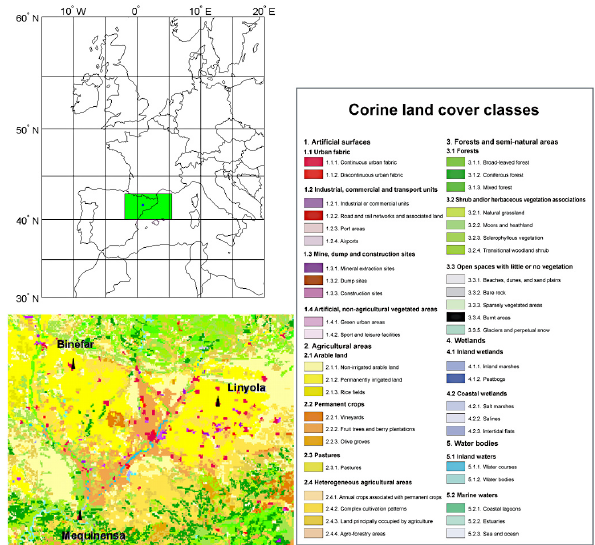
Fig. 1. Location map of the Linyola’s area and the land uses around each vertex belonging to the CAS (Linyola, Mequinensa and Binefar) according to CORINE2000 database (European En- vironment Agency; http://www.eea.europa.eu/data-and-maps/data/ corine-land-cover-2000-clc2000-seamless-vector-database)